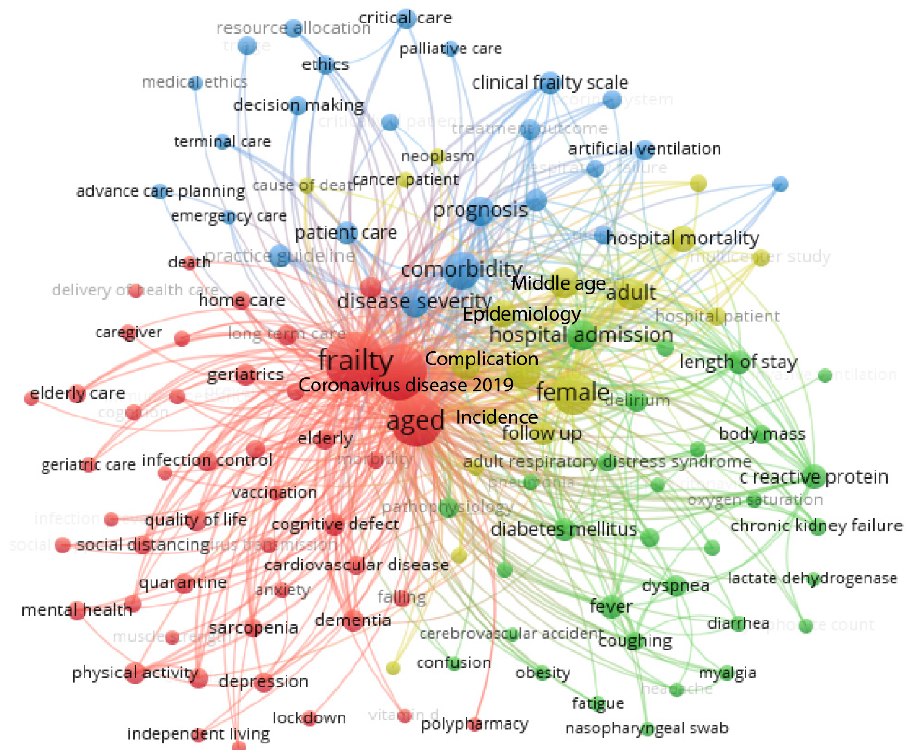
Figure 2. Distribution of searching terms on recently published papers about Frailty and COVID-19. Figure created with VOSviewer version 1.6.16 software. The results are based on the threshold of 252 terms (from 3672 keywords) with four clusters, where each node or circle in the map represent a term at least 10 times and the node or circle is proportional to the number of occurrences of that term, data obtained from SCOPUS database using the search pattern TITLE-ABS-KEY: Frailty AND COVID-19 (Accessed on May 22 2021). Table 3. Direct efects of COVID-19 in frailty patients.